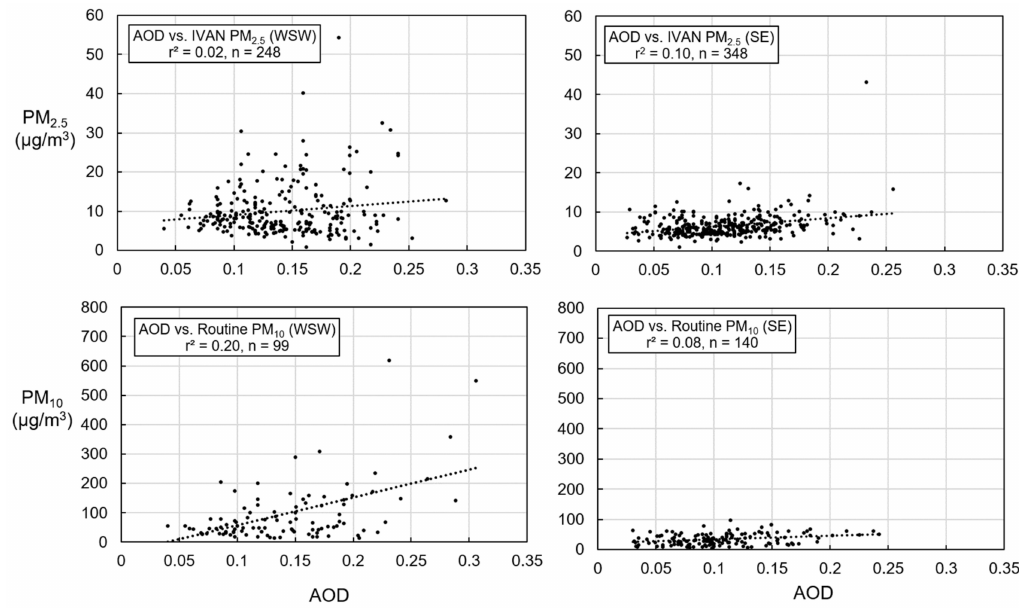
Figure10. ScatterplotsandregressionstatisticsofpairedMAIACAODandmeasuredPMconcentrations at overpass hour; ( top left ) AOD versus IVAN PM2.5 for the WSW set, ( top right ) AOD versus IVAN PM2.5 for the SE set, ( bottom left ) AOD versus routine PM10 for the WSW set, and ( bottom right ) AOD versus routine PM10 for the SE